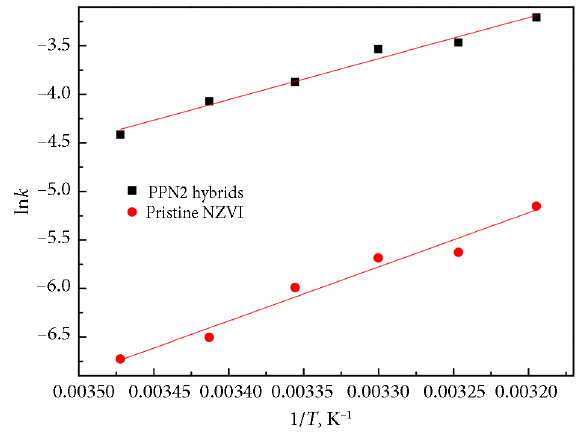
Figure 9. Conceptual model for possible removal pathways of Cr(VI) by PPN